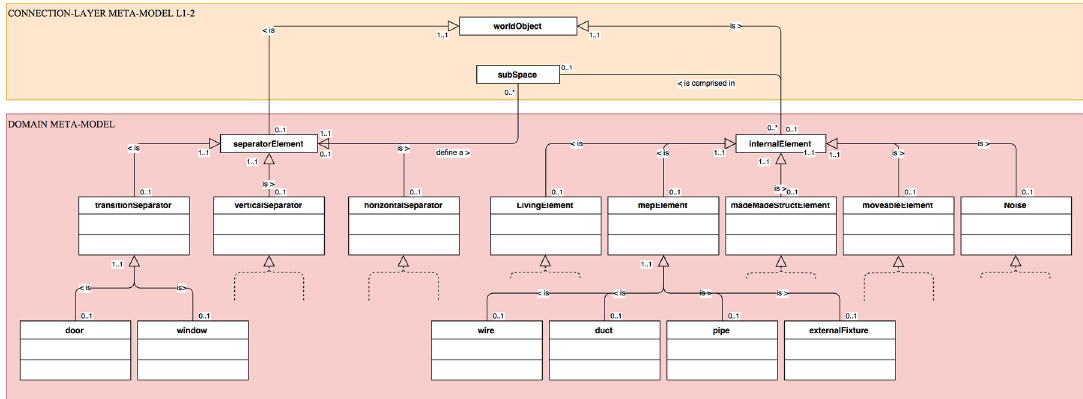
Figure 5 Level-2 meta-model example. separatorElement and internalElement are connected to the Level-1 meta- model directly through “worldObject” and “subSpace”. It is a succession of specialization describing an indoor